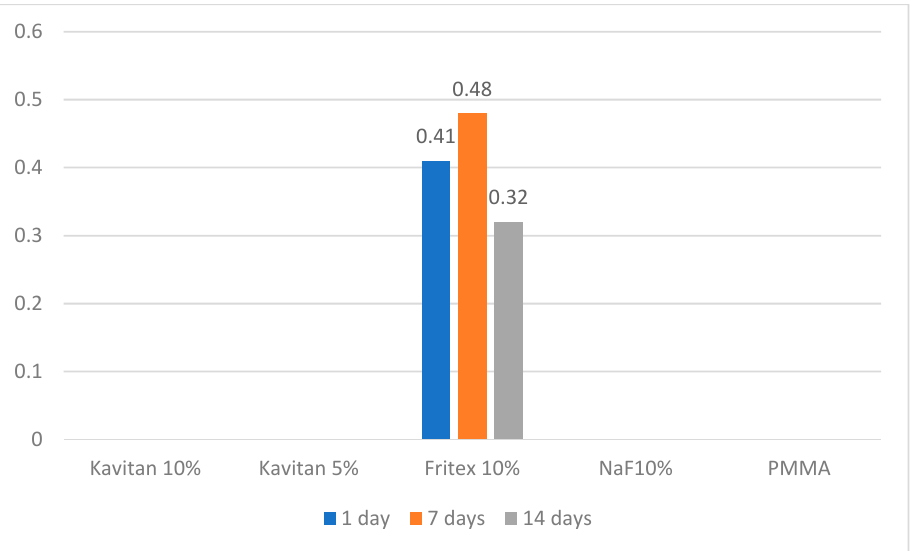
Figure 2 . Fluoride release with time of storage.